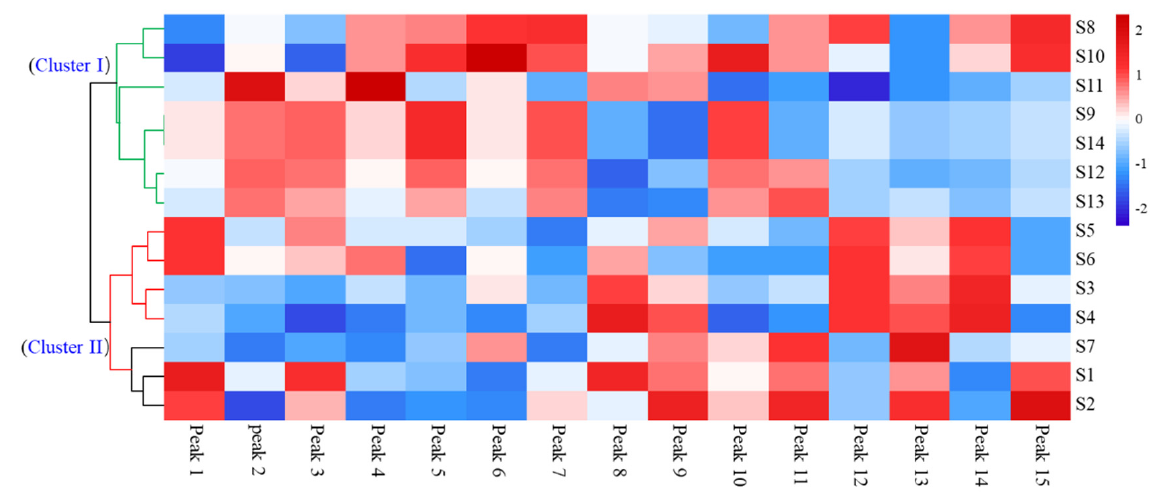
Figure 4. Dendrogram and heatmap of A. quinata leaves from Gongju and Muju.